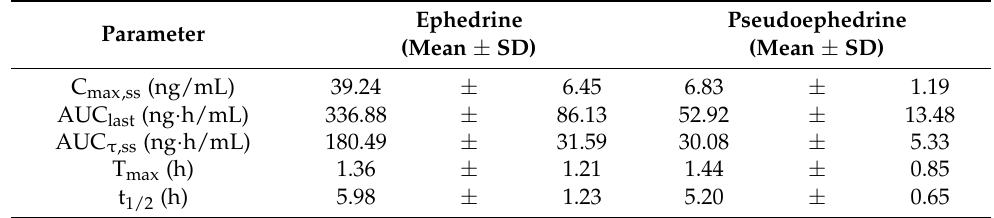
C max,ss , peak plasma concentration at steady-state; AUC last , area under the plasma drug concentration-time curve to the last measurable time; AUC τ ,ss , area under the plasma drug concentration-time curve during dosing interval at steady-state; T max , time to reach the peak plasma concentration; t 1/2 , terminal